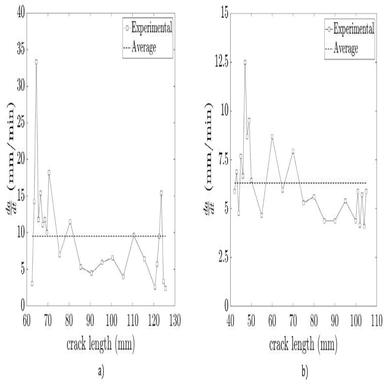
Crack growth rates in (a) rigid adhesive samples (T1-02) and (b) flexible adhesive samples (T2-01), tested at a displacement rate of 2 mm/min.